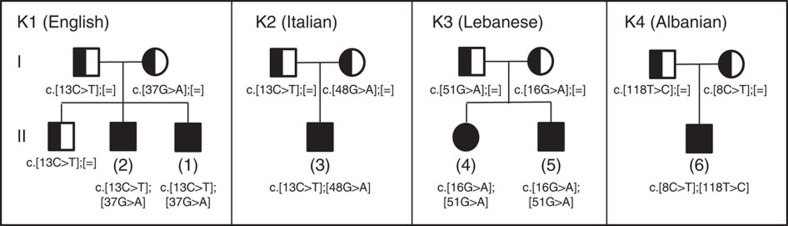
Pedigree of the six Roifman Syndrome cases (kindred 1–4).The pedigrees show the RNU4ATAC compound heterozygous SNVs in the six genotyped cases of Roifman Syndrome; [=] indicates no variant detected.